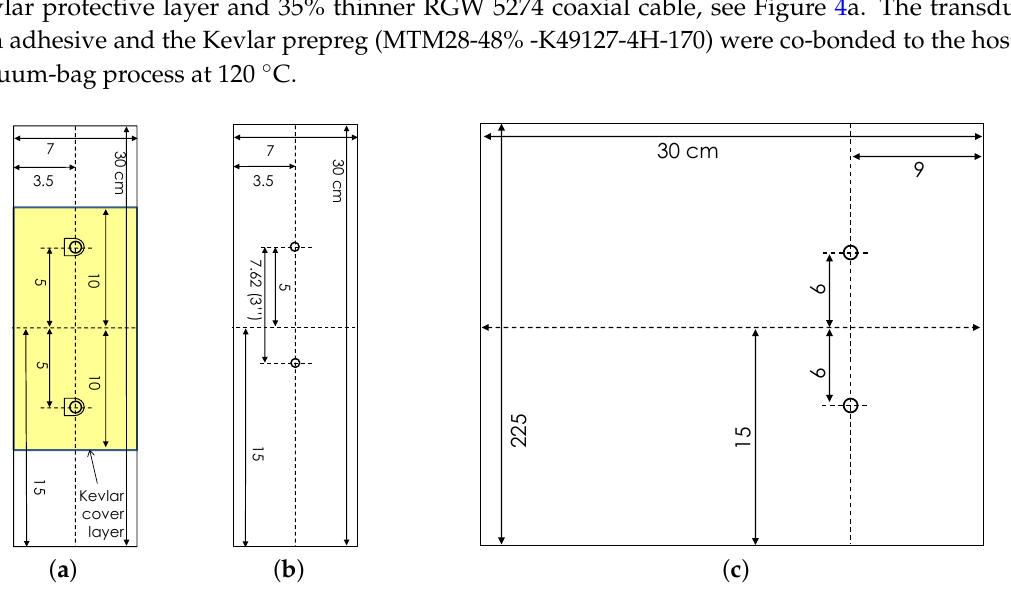
Figure 4. ( a ) Sample 1 without Kevlar layer and Sample 2 with Kevlar layer; ( b ) Sample 3 (Smart Layer) schematic; ( c ) Sample 4 (SHM layer)